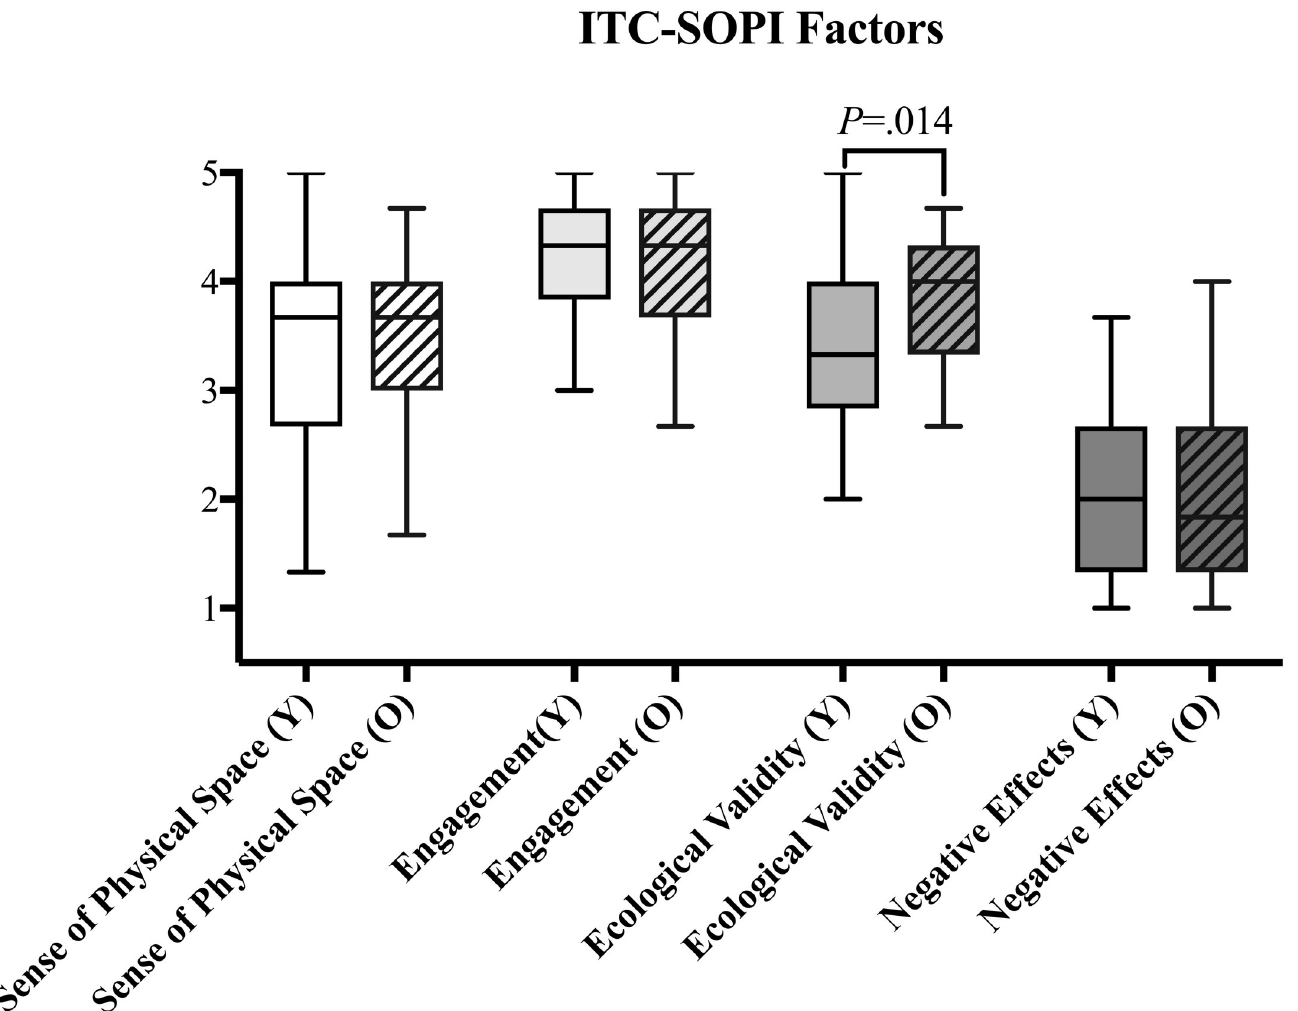
Fig 5. Boxplot of Presence factors for the Younger group (Y) and Older group (O), showing almost equally large variabilities in both groups and similar medians, except for ecological validity. This factor shows significantly larger differences in the medians and the variability of the groups being larger for the Younger group. Whiskers indicate the 25th and 75th